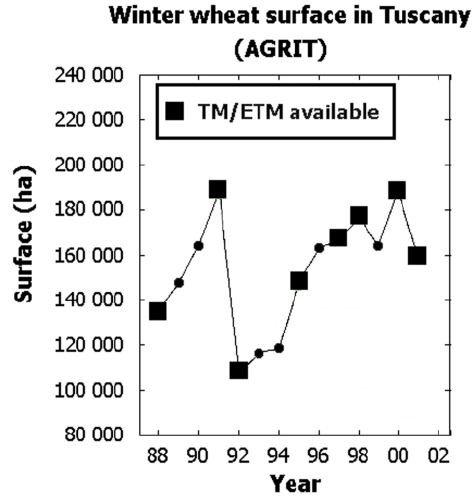
Figure 4. Reference winter wheat surface data for the region of Tuscany, Italy (source: AGRIT [30]). Large squares indicate the eight years for which high resolution TM/ETM+ imagery is